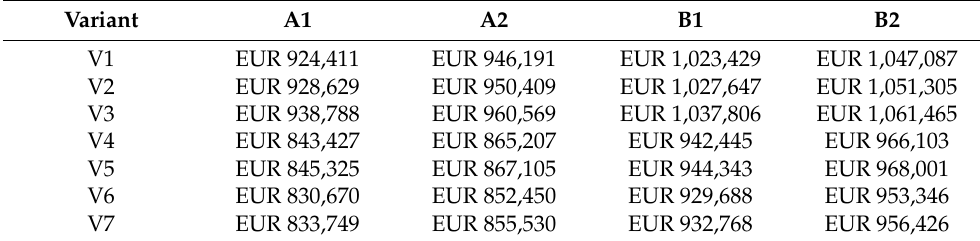
Table 7. Total costs for installation and dismantling of lighting poles.